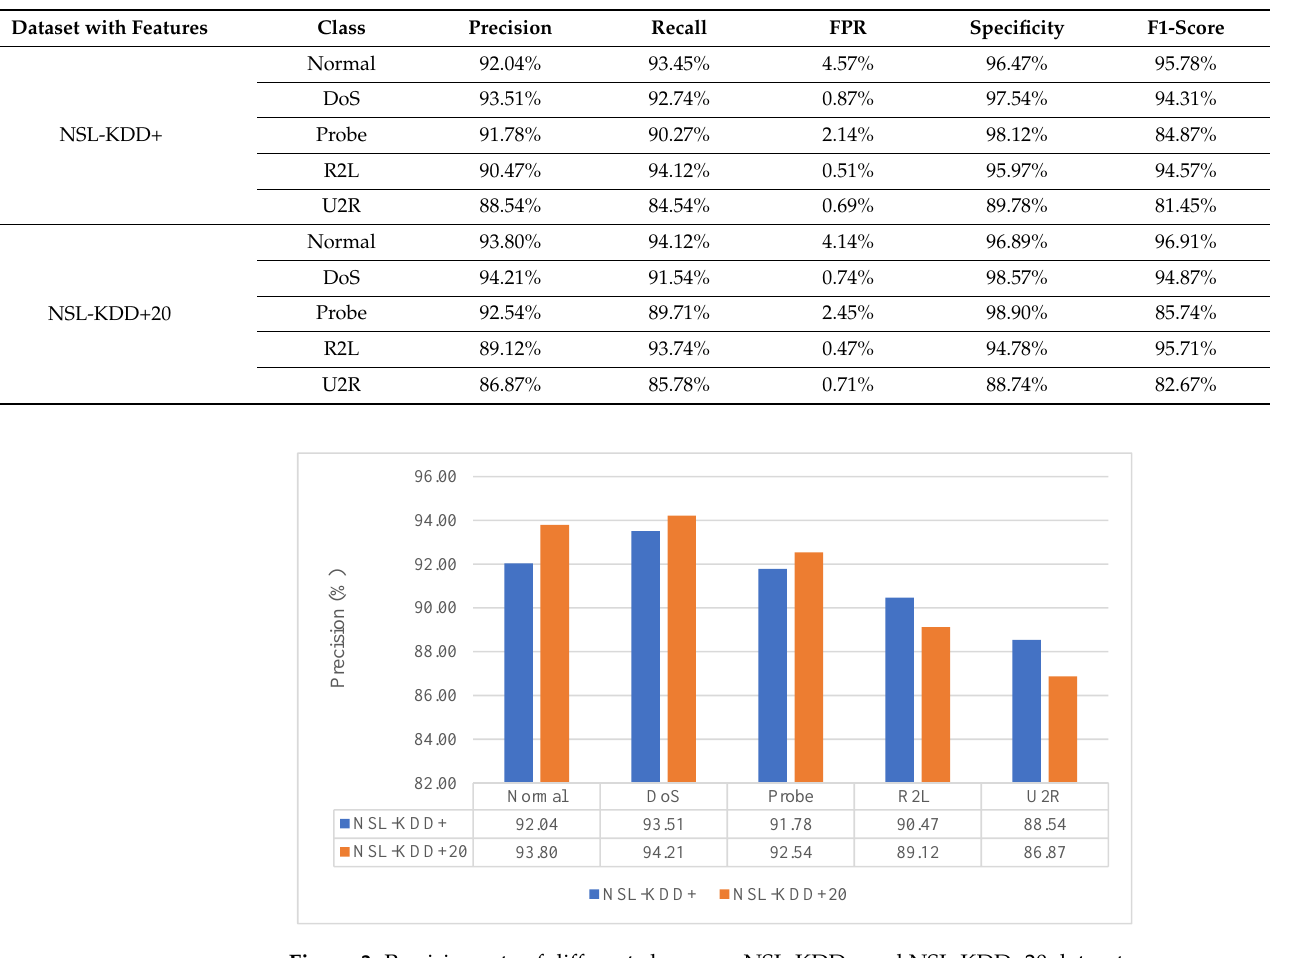
Figure 5. Specificity rate of different classes on NSL-KDD+ and NSL-KDD+20 datasets.